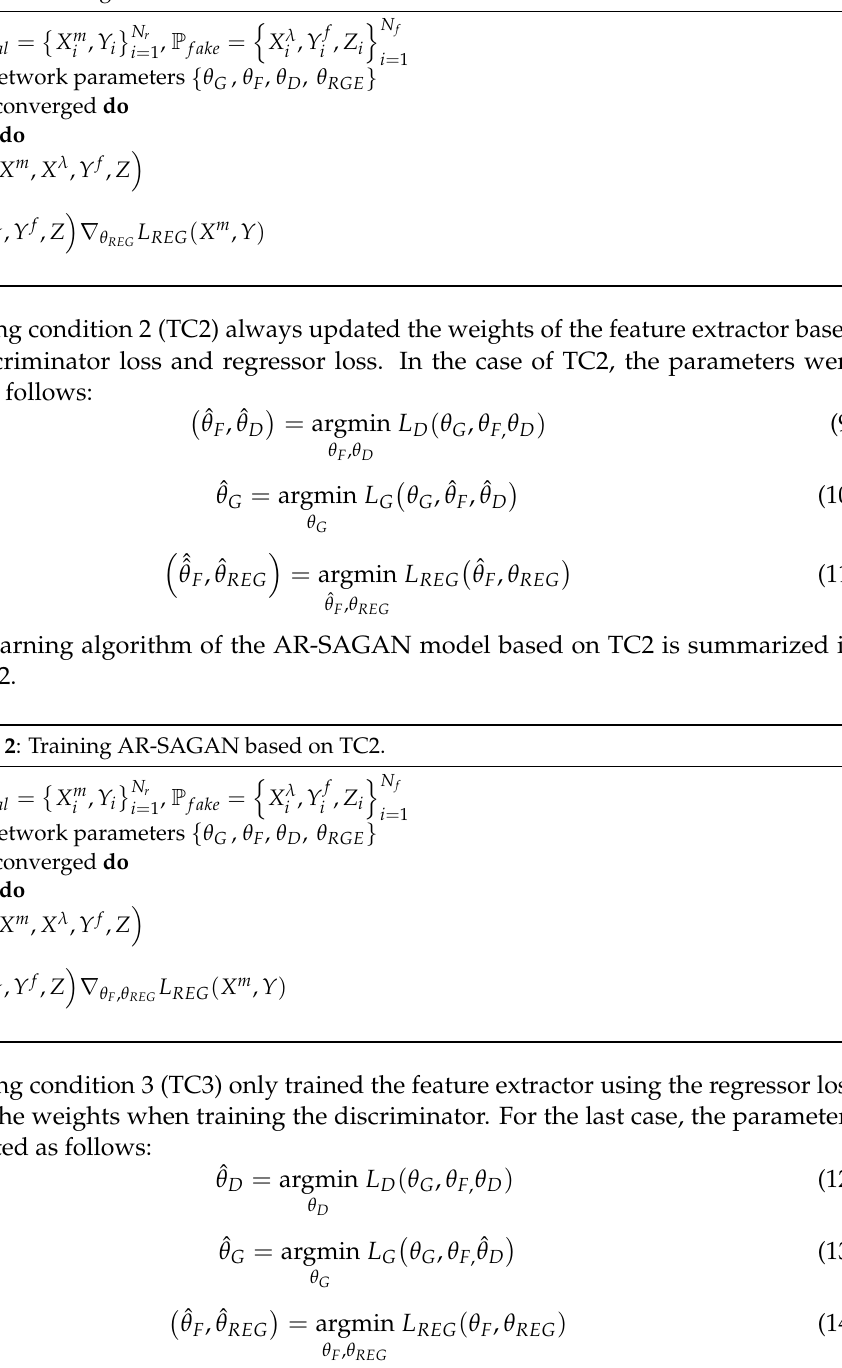
Algorithm 1 : Training AR-SAGAN based on TC1.